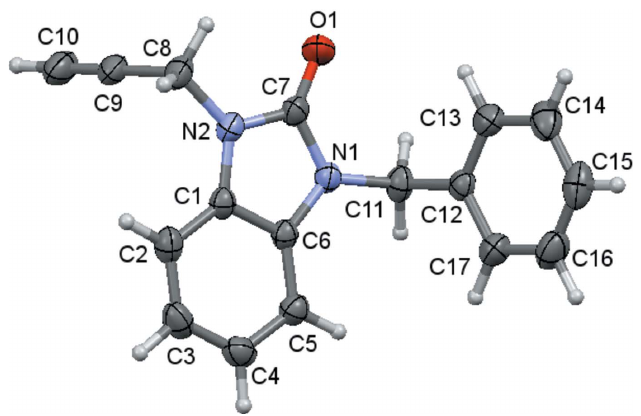
Figure 1 The molecular structure of the title compound with the atom-numbering scheme. Displacement ellipsoids are drawn at the 30% probability